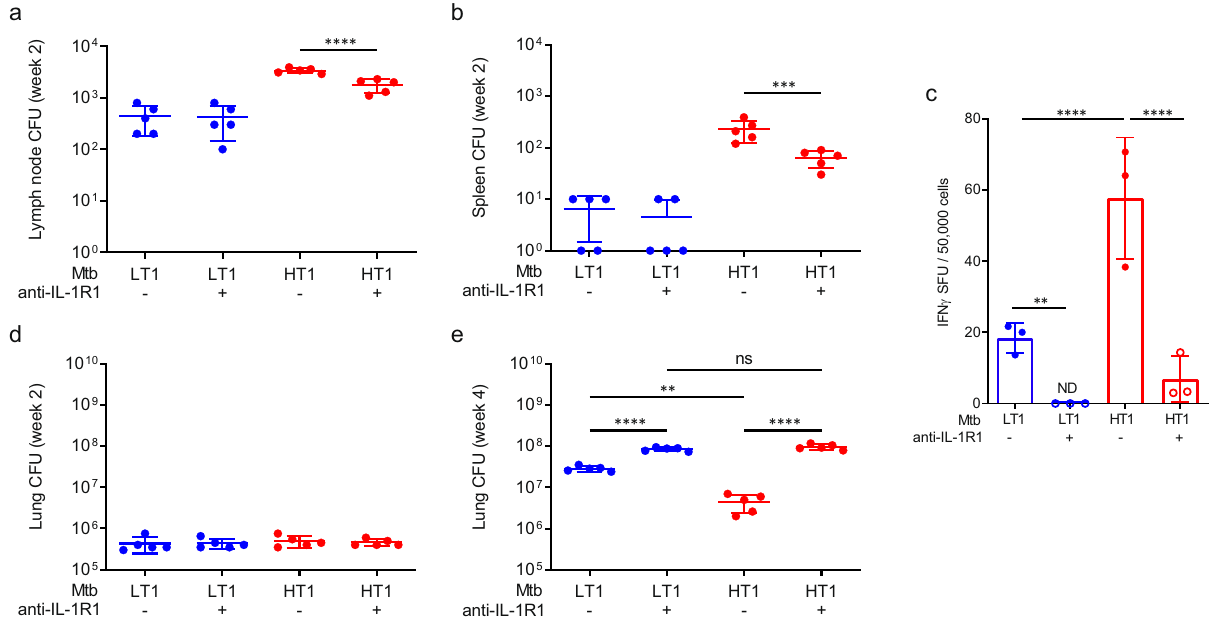
Fig. 7 Rapid T cell priming and control of bacterial replication in Mtb-HT infection is dependent on IL-1R1 signaling. C3HeB/FeJ mice were infected with ~100 CFU of the indicated strain via Glas-Col aerosol exposure. On days 8, 10, and 12 post infection 200 μ g of α -IL-1R1 antibody ( + ) or isotype control ( − ) was administered to the mice. Bacterial burden was determined at 2 weeks in the mediastinal lymph nodes ( a ), spleen ( b ), and lung ( d ) and at 4 weeks in the lung ( e ). At 2 weeks of infection, the frequency of IFN γ -secreting T cells was measured by ELISPOT, and data are presented as spot forming units (SFU)/50,000 LN cells. Data are presented as mean values + / − SD. Source data are provided as a Source Data fi le. Sample size of n = 5 mice were included for panels ( a , b , d , e ) and sample size of n = 3 mice was included for panel ( c ). Signi fi cance was determined using one-way ANOVA with Tukey ’ s correction. ** P = 0.0064 (panel c ), ** P = 0.0032 (panel e ), ** P < 0.01, *** P < 0.001, **** P < 0.0001. The data are representative of one of two individual experiments with Mtb-HT1 and